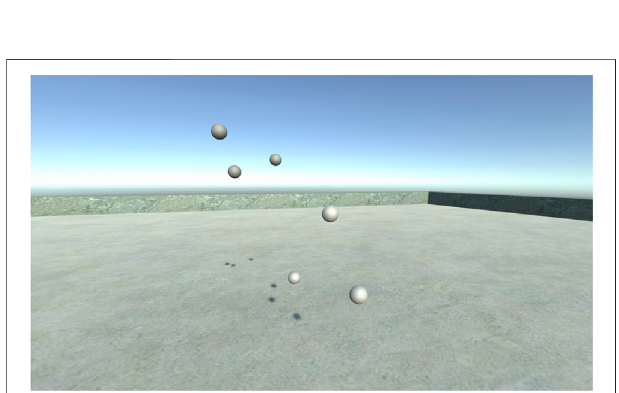
FIGURE 1 | On the left: Two participants testing the platform during the ENSAD public event.